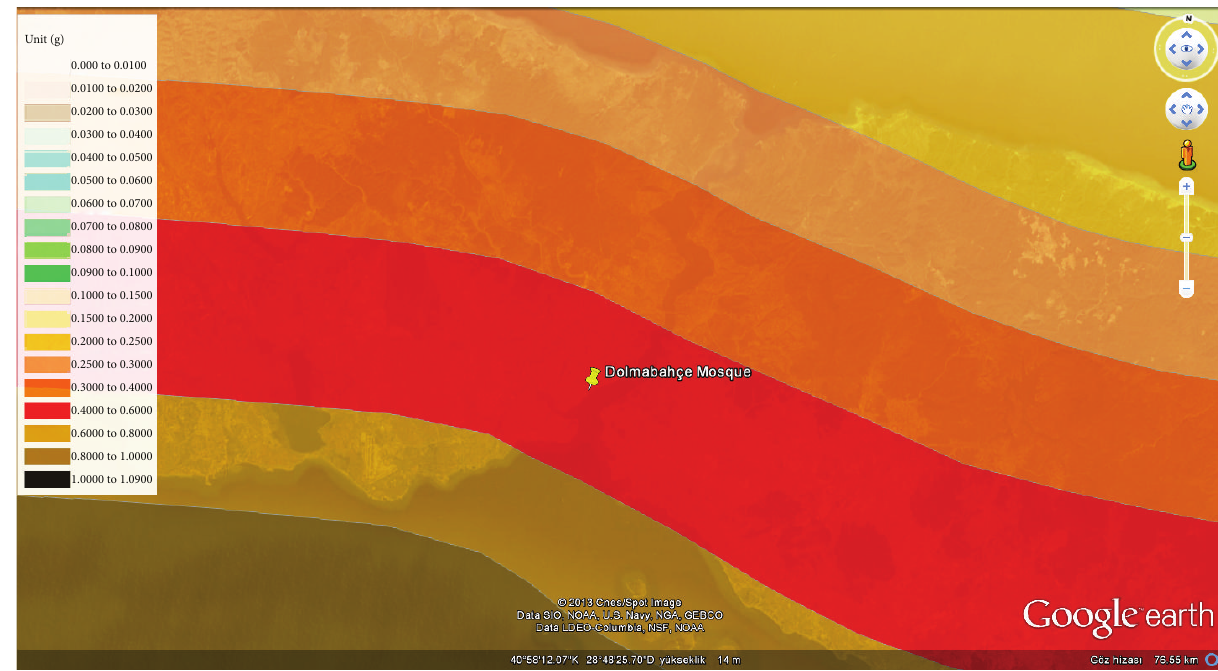
Figure 7: Maximum peak ground acceleration map for 475 years return period (10% exceedance in 50 years) [31–33].